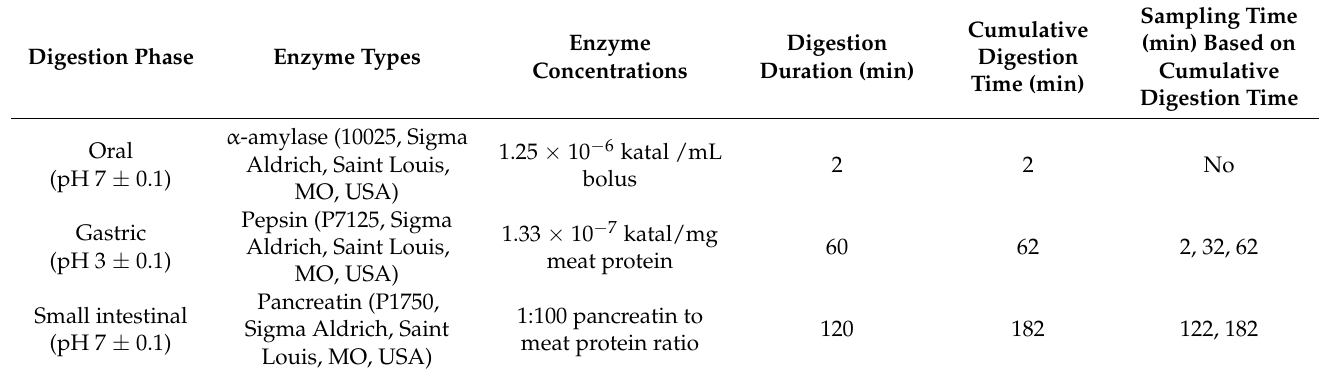
Table 1. Digestive enzyme types and concentrations, digestion duration and sampling time points for each digestion phase (oral, gastric and small